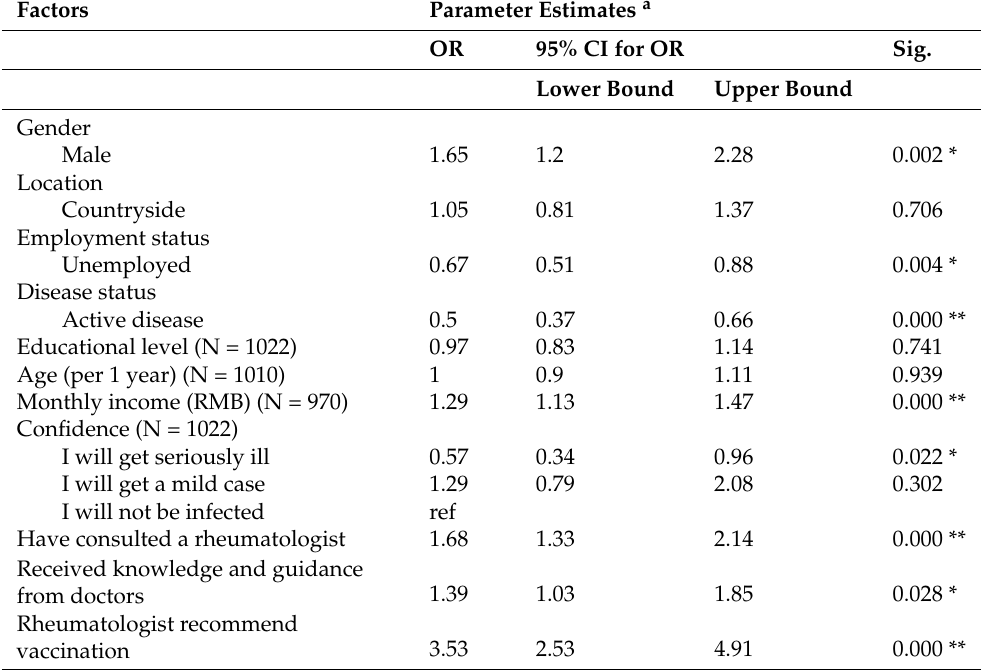
Table 2. Logistic regression analysis of attitudes toward COVID-19 vaccines.